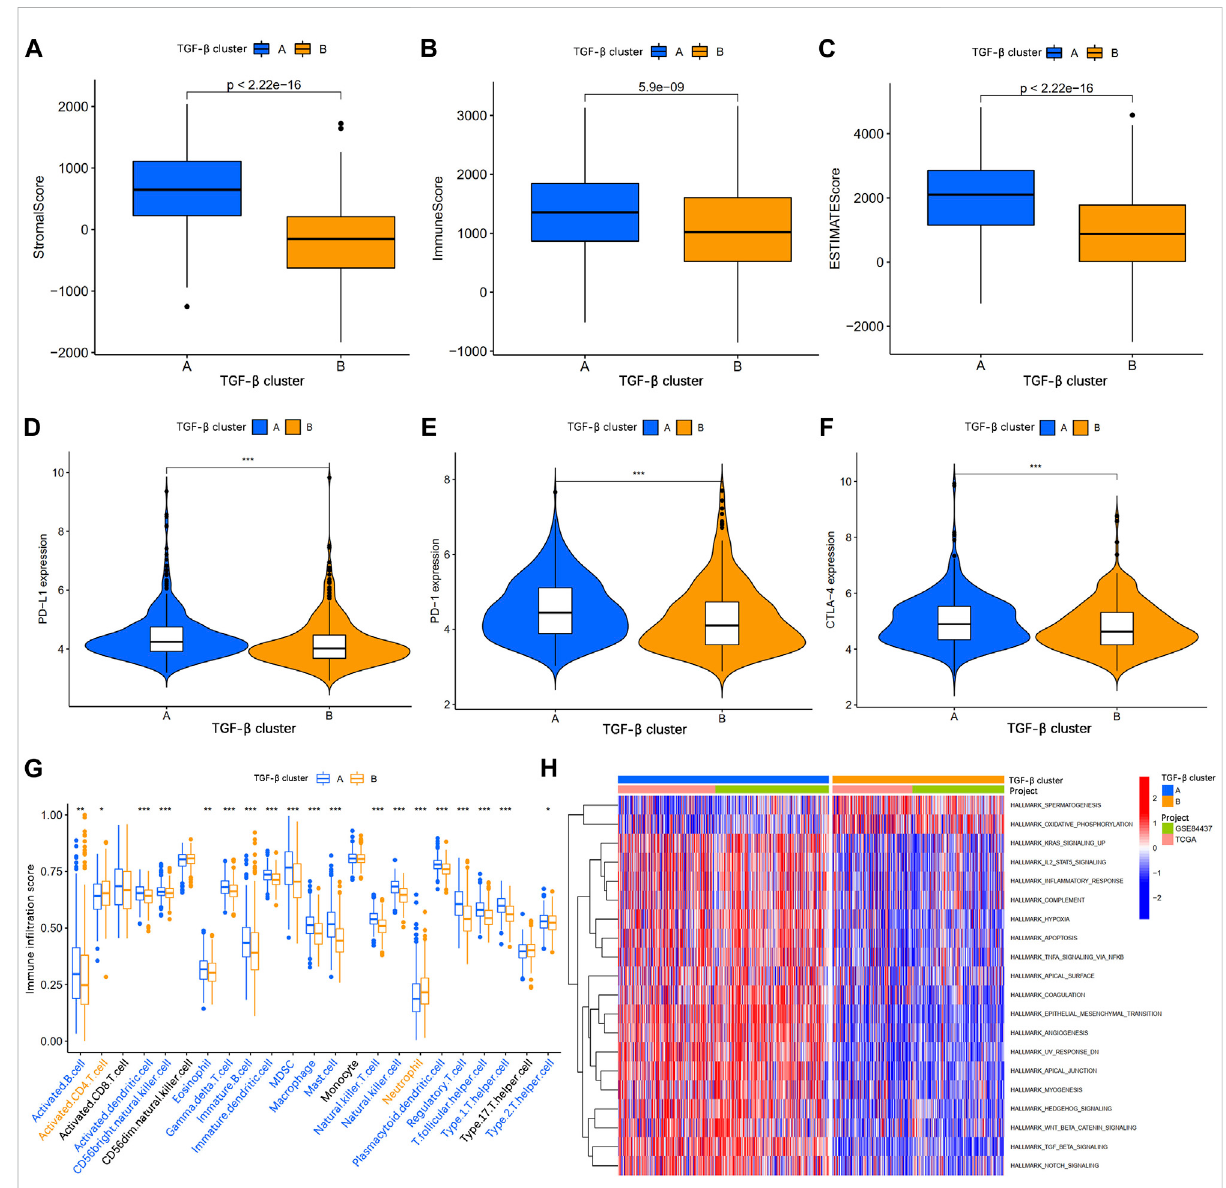
FIGURE 3 AnalysisofthetumorimmunemicroenvironmentbetweentwodifferentTGF- β subgroups. (A – C) Stromalscore,immunescore,andESTIMATE score analyses between two subgroups. (D – F) Expression levels of PD-1, PD-L1, and CTLA-4 in the two subgroups. (G) The abundance of 23 in fi ltrating immune cell types in the two different TGF- β subgroups. (H) GSVA of biological pathways between two subgroups. GSVA, gene